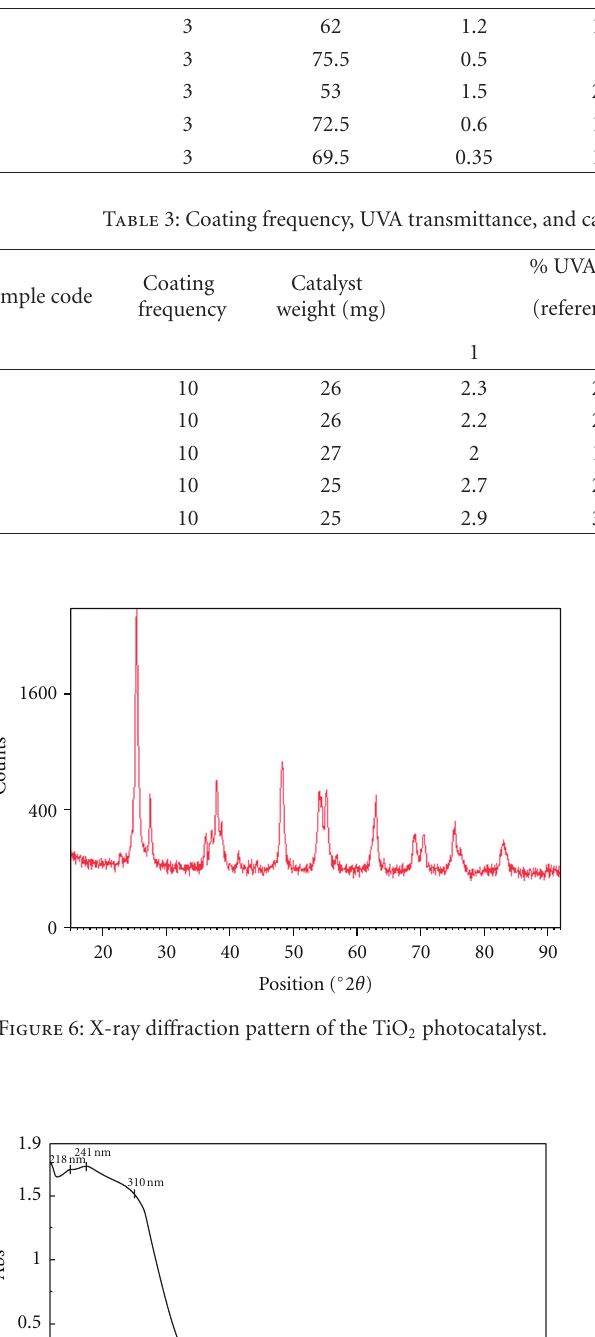
Table 2: Coating frequency, UVA transmittance, and catalyst coating weight results for the dip coating technique. Sample code